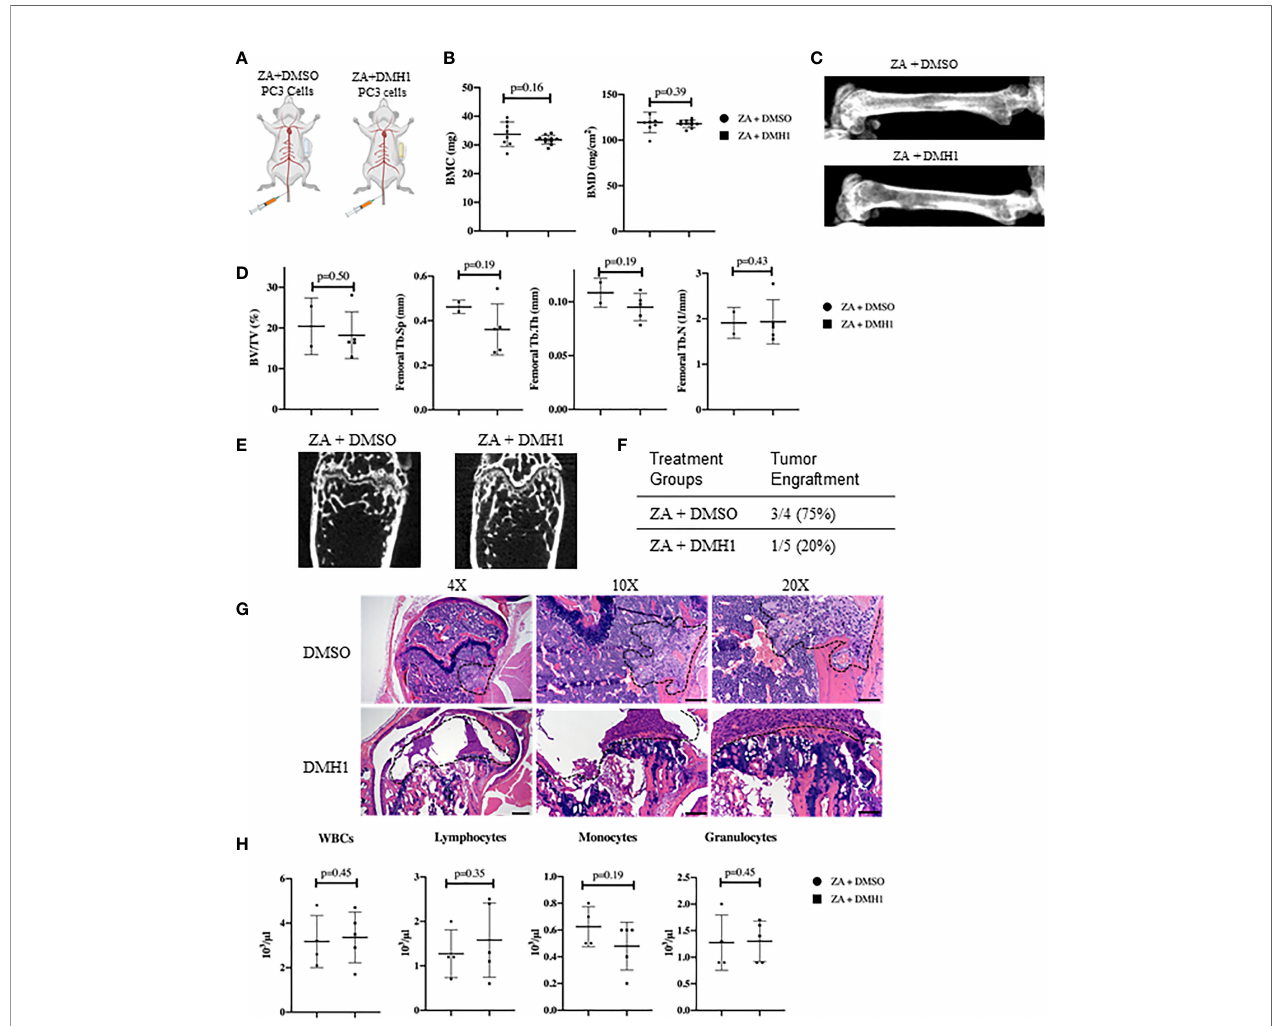
FIGURE 3 | Caudal Artery Injected Human PC3 Osteolytic Prostate Cancer Cells Have Reduced Engraftment with BMP Inhibition. (A) Nine male 8 week old NSG mice received 50,000 PC3 cells via caudal artery injection. All mice received an IP injection of zoledronic acid, and subcutaneous 4 week osmotic pump implant containing DMSO (n=4) or DMH1 (n=5). (B) BMC and BMD measurements from femur of DXA imaging. (C) Representative DXA images of the femur from each treatment group. (D) µCT data analyzed from femur trabecular bone (DMSO n=2, DMH1 n=5 analyzed for quanti fi cation). (E) Representative Femoral µCT images. (F) Analysis of tumor incidence, with the DMSO treated group (n=4) having three mice with metastatic tumors in bone, while the DMH1 treatment (n=5) group having one mouse with metastatic tumor in bone. (G) H&E representative images of tumor invasion located in the femurs. (H) Complete Blood Count (CBC) from peripheral blood at time of euthanasia. Scale bars for 4X, 10X and 20X are 200µm, 100µm and 50mm respectively. Statistical signi fi cance was determined using a Mann- Whitney U test and error bars indicate